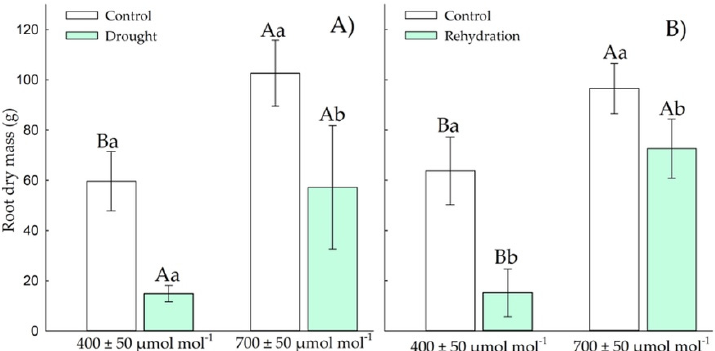
Figure 11. Effects of CO 2 concentration ( a [CO 2 ] = 400 µ mol mol − 1 and e [CO 2 ] = 700 µ mol mol − 1 ) and drought stress in A. buniifolius in root dry mass. In plants sampled after drought stress ( A ) and rehydration ( B ) period. Different uppercase letters indicate a significant difference between values in different CO 2 within the same water treatment, while different lowercase letters indicate significant differences between values of different water treatments within each CO 2 level by Tukey’s test ( p ≤ 0.05). ns denotes non-significance ( p > 0.05). Error bars represent a 95% confidence interval.